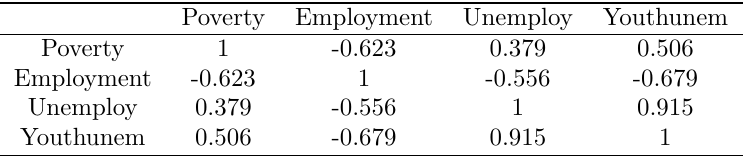
Correlation matrix of the four variables